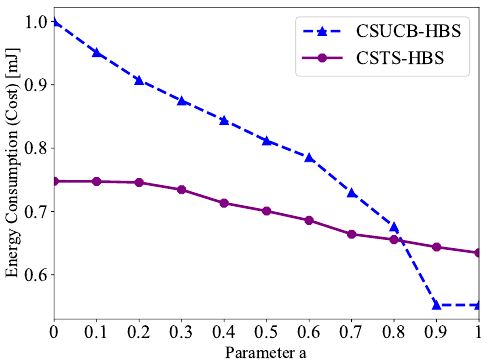
Figure 2. The energy consumption (cost) vs. subsidy parameter a at r = 10 and no blocking.